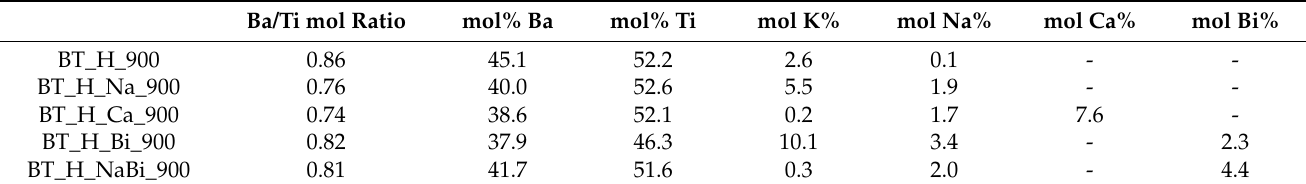
Table 4. Experimental molar composition of BaTiO 3 -doped samples from ICP-OES results. Ba/Ti mol Ratio mol% Ba mol% Ti